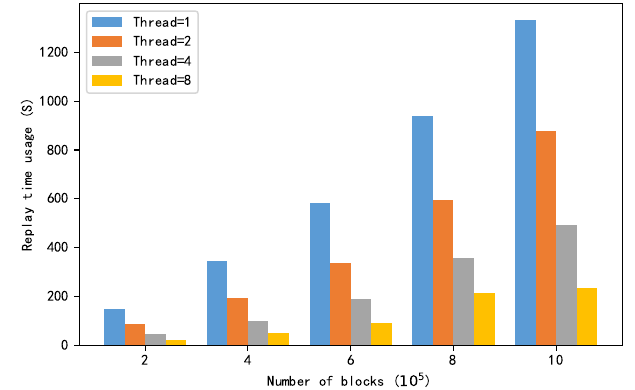
Figure 14. Comparison of the playback times for different